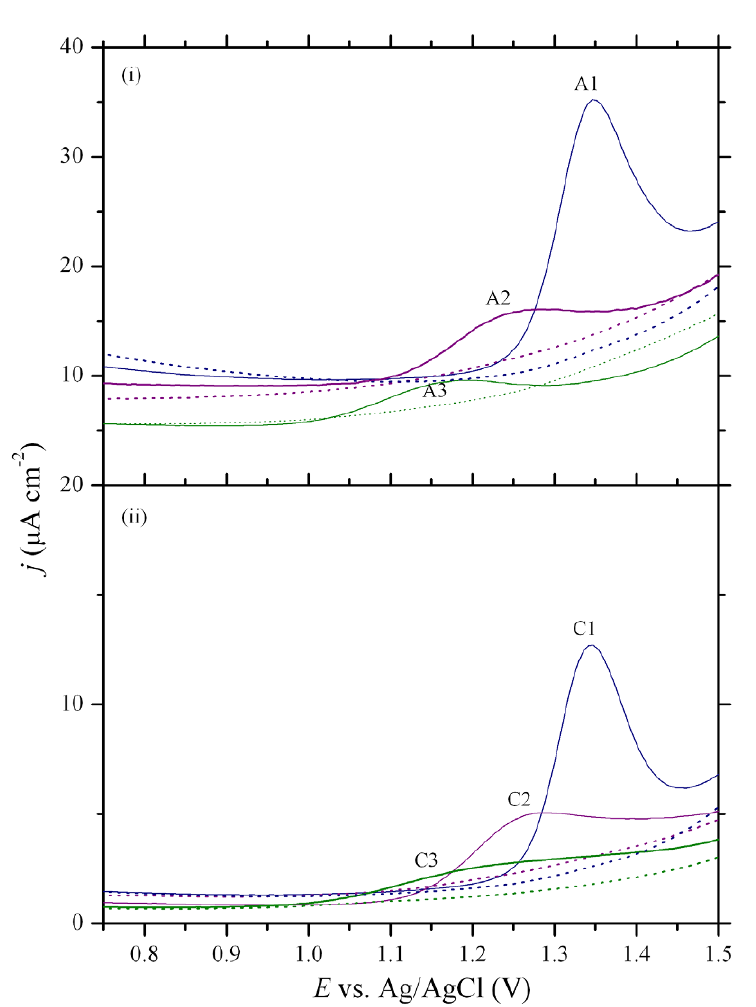
Figure 4. The effect of pH on the DP voltammograms of linuron (0.034 μmol cm -3 ) recording by (i) boron doped glassy carbon (A) and (ii) GC-Metrohm (C) electrodes. Legend: 1 - pH = 0.7; 2 - pH = 4.0 and 3 - pH = 7.0. The experimental conditions: voltage